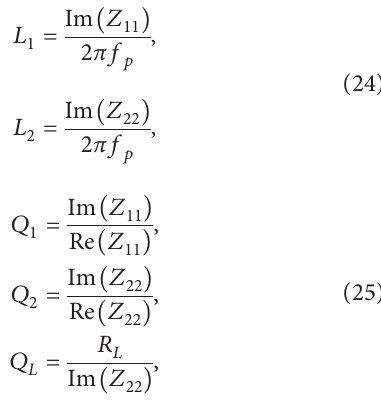
Table 3: Dielectric properties of tissues ( f